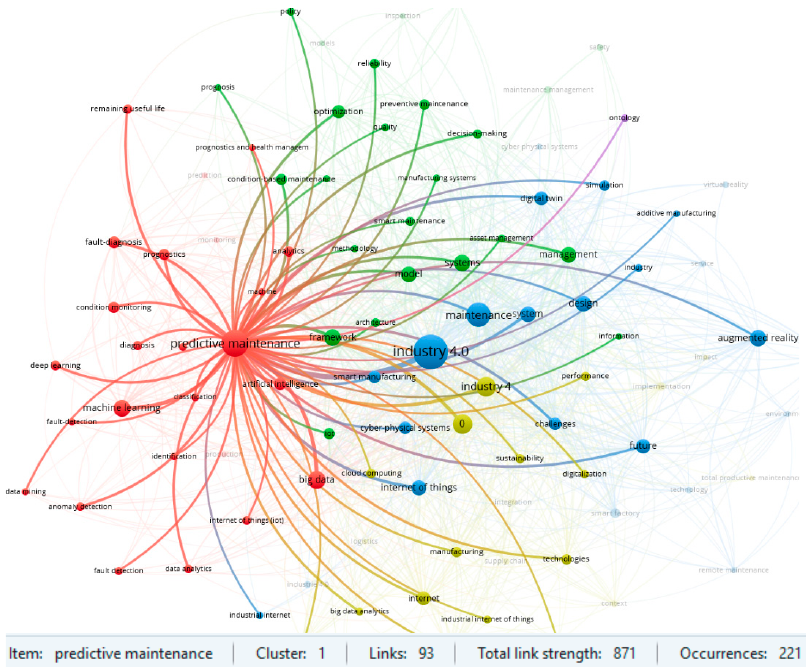
Figure 14. Analysis of keyword strength for the first cluster of publications from the WoS database. Source: own development using VOSviewer software [101].